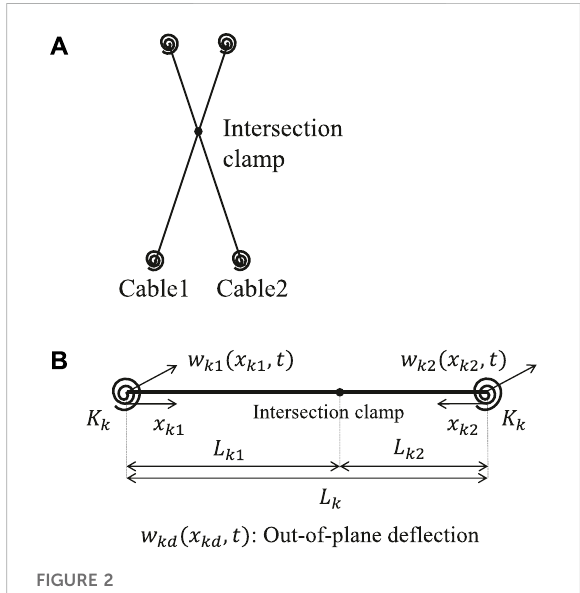
FIGURE 2 Target model. (A) Model of two cables connected by intersectionclamp. (B) Directionofcoordinateaxesandde fl ection in element coordinate